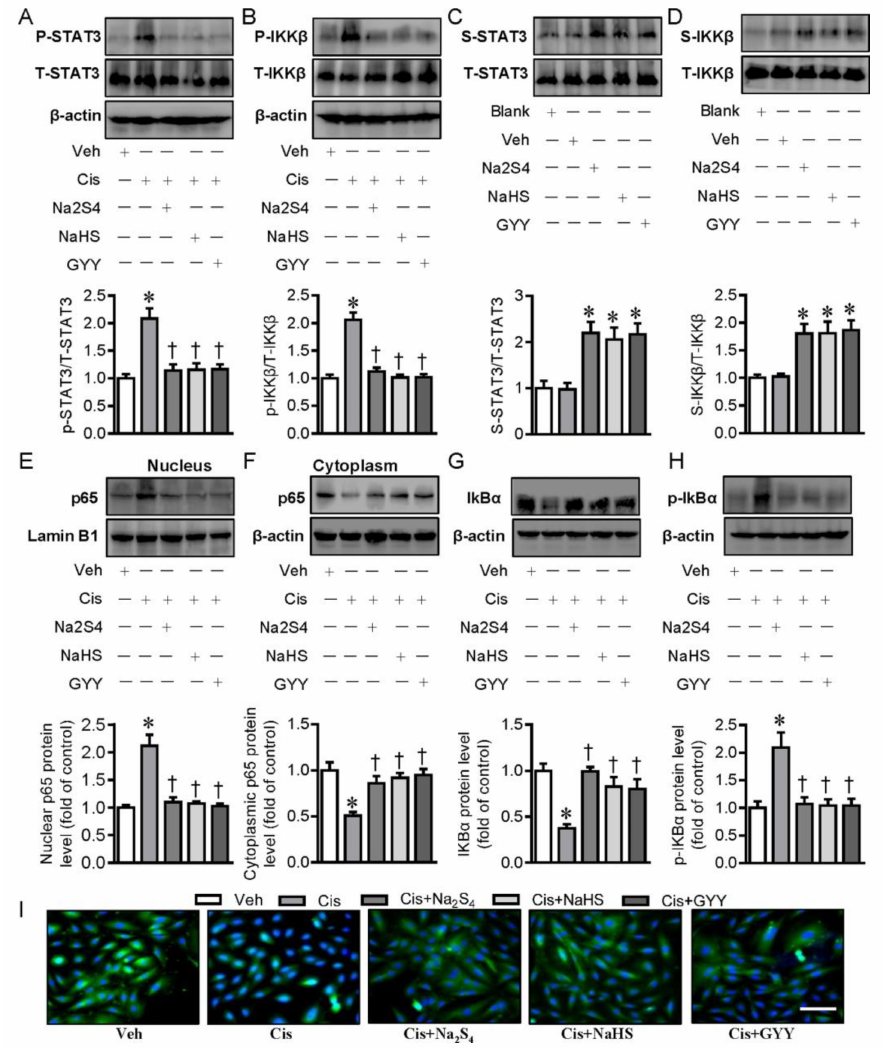
Figure 2. Both Na 2 S 4 and NaHS attenuated the activation of transcription 3 (STAT3) and inhibitor kappa B kinase β (IKK β ) signaling in LLC-PK1 cells treated with cisplatin. ( A ) Representative blots of P-STAT3 (PhosphorylatedSTAT3). ( B )RepresentativeblotsofP-IKK β (PhosphorylatedIKK β ). ( C )Representative blots of STAT3 persulfidation. ( D ) Representative blots of IKK β persulfidation. ( E ) Representative blots of nuclear p65 nuclear transcription factor kappa B (NF- κ B). ( F ) Representative blots of cytoplasmic p65 NF- κ B. ( G ) Representative blots of nuclear factor kappa B inhibitor protein alpha (I κ B α ). ( H ) Representative blots of P-I κ B α (Phosphorylated I κ B α ). ( I ) Representative immunofluorescence images of p65 NF- κ B. Scale bar = 50 µ m. * p < 0.05 vs. Vehicle (Veh), † p < 0.05 vs. Cisplatin